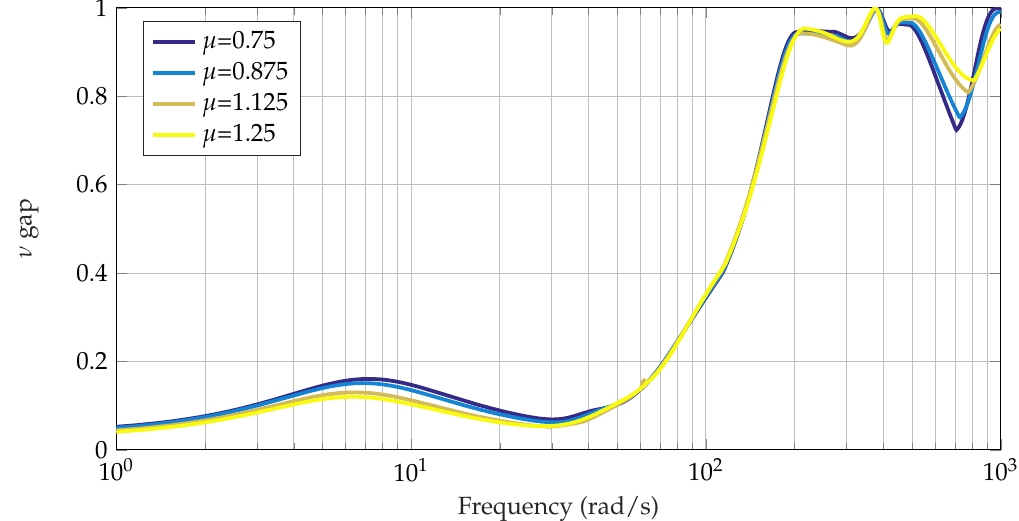
Figure 16. ν -gap metrics comparing ‘bottom-up’ models to the corresponding full-order models. In addition to the ν -gap values, the bode plots of 40 and 104 state models are compared in Figures 17 and 18. In these figures the colors represent the µ parameters of the control oriented model, while the grey plots are of the full order model. It can be also observed that the bode plots match very well within the frequency range of interest.